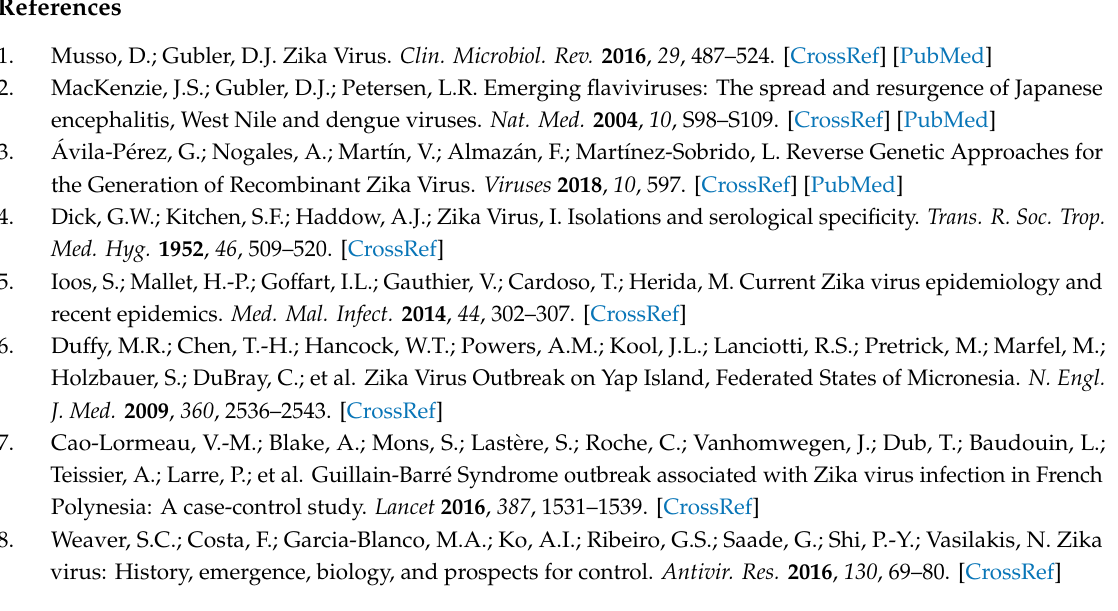
Figure S1: Cytotoxicity of the ten tested compounds, Table S1: Maximum e ff ective concentration e ff ects of the compounds post-, co-, and pre-treatment in Vero cells, Table S2: Maximum e ff ective concentration e ff ects of the compounds with old World ZIKV MR-766 strain and new World ZIKV PRVABC59, Table S3: Maximum e ff ective concentration e ff ects of the compounds in A549